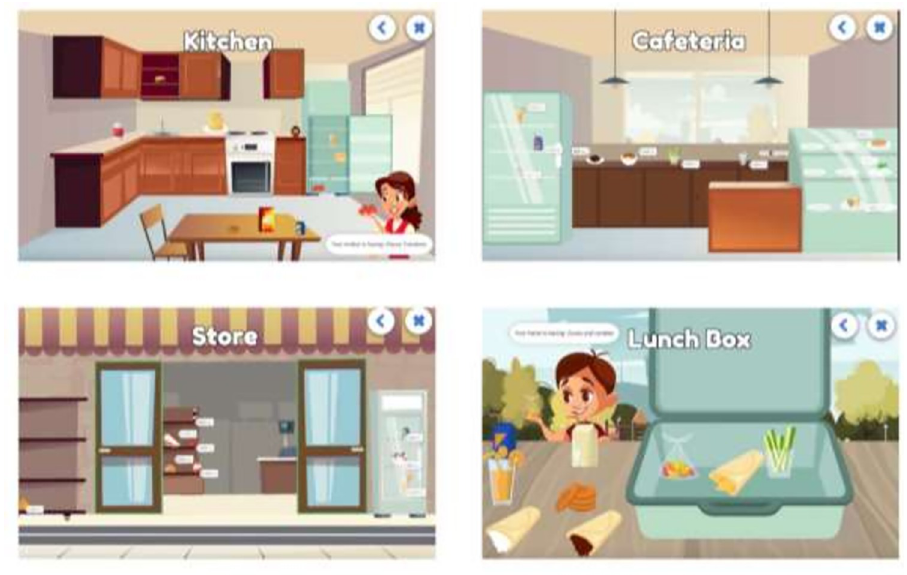
Fig 2. Examples of different scenarios and choice tasks from the choice